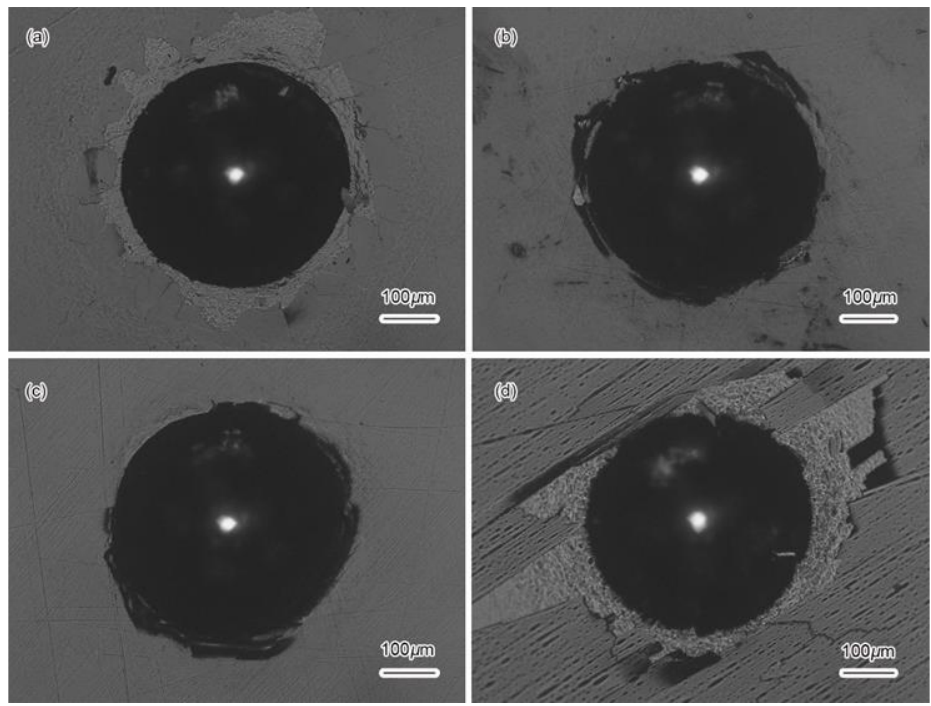
Figure 9. Indentation morphologies of Cu films: ( a ) 2 A, ( b ) 8 A, ( c ) 13 A, and ( d ) 18 A .